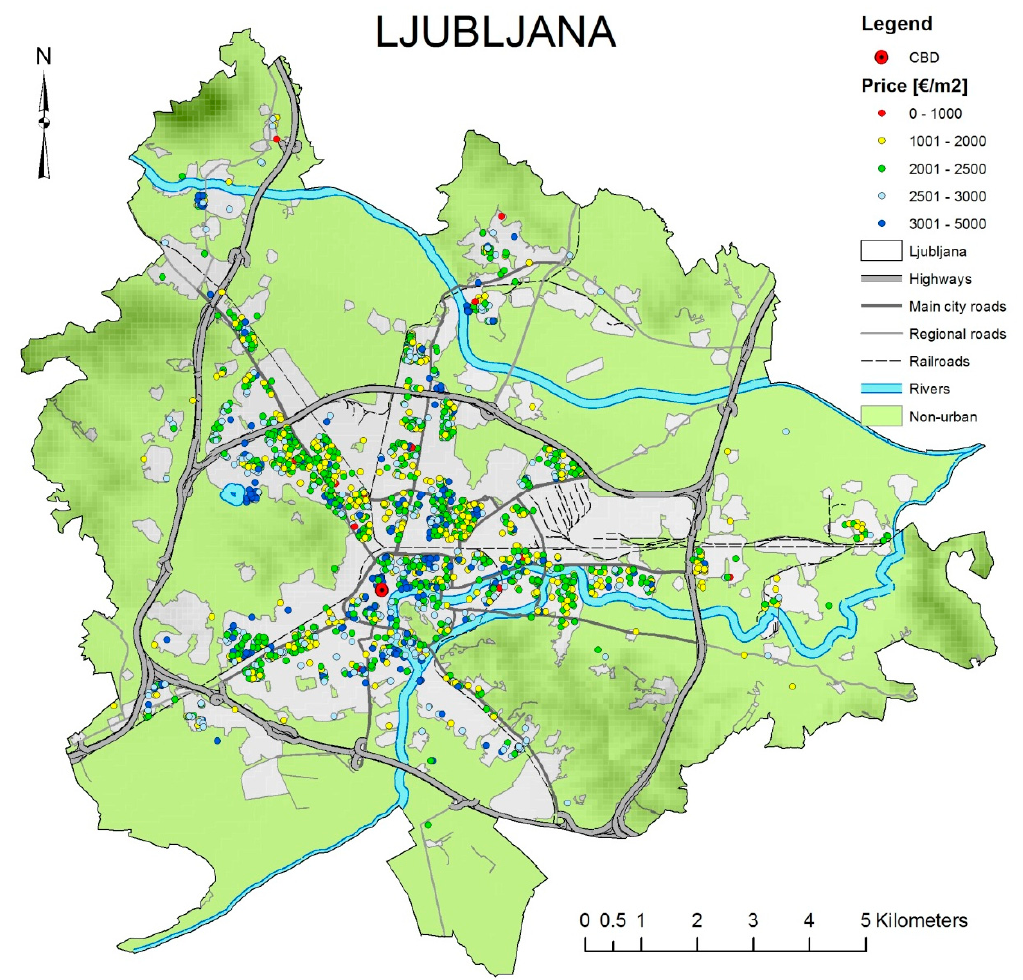
Figure 1. Observed transactions of apartments in Ljubljana in the period from 2008–2013.